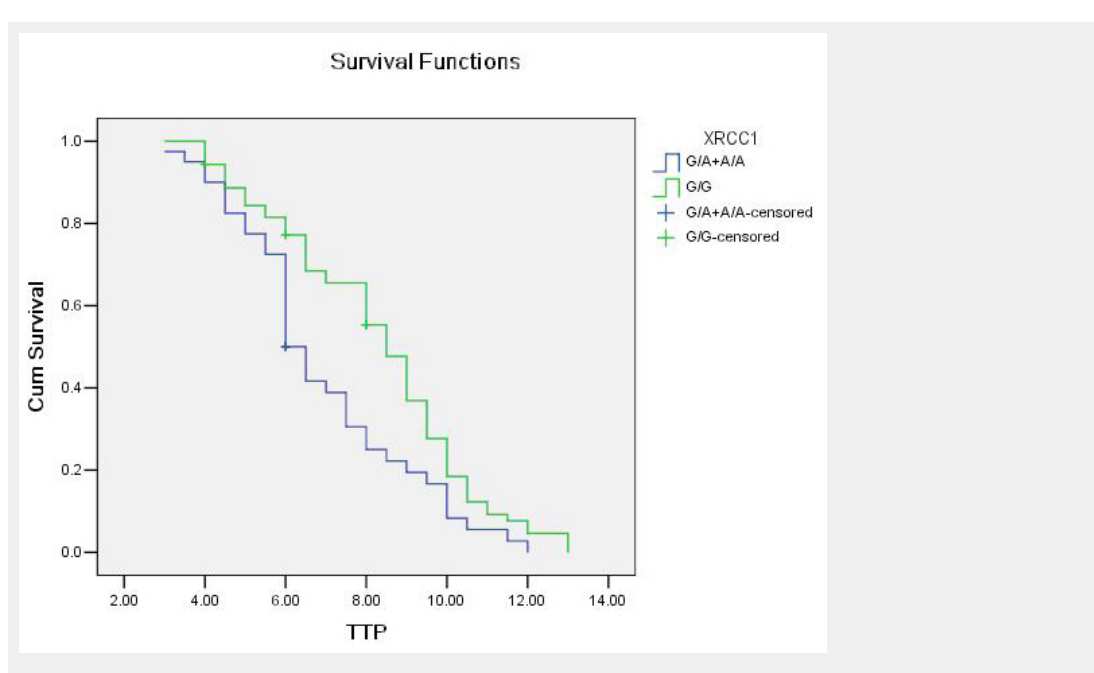
Figure 2 Association between XRCC1G28152A genotypes (G/A and A/A as a combined group) and time to progression (TTP) in patients with advanced NSCLC receiving platinum- based chemotherapy. The vertical hash marks denote the time of last follow up for those patients lost to follow